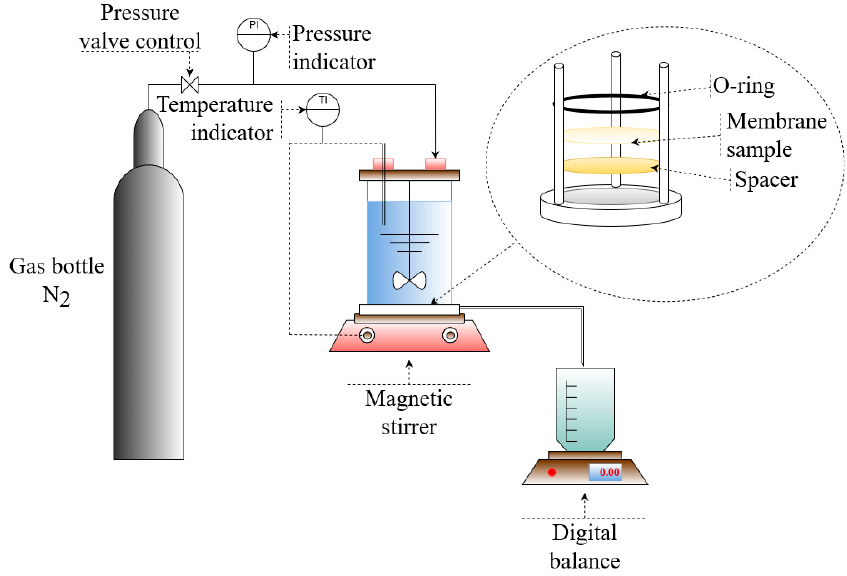
Figure 1. Amicon dead-end filtration system’s schematic configuration [38].